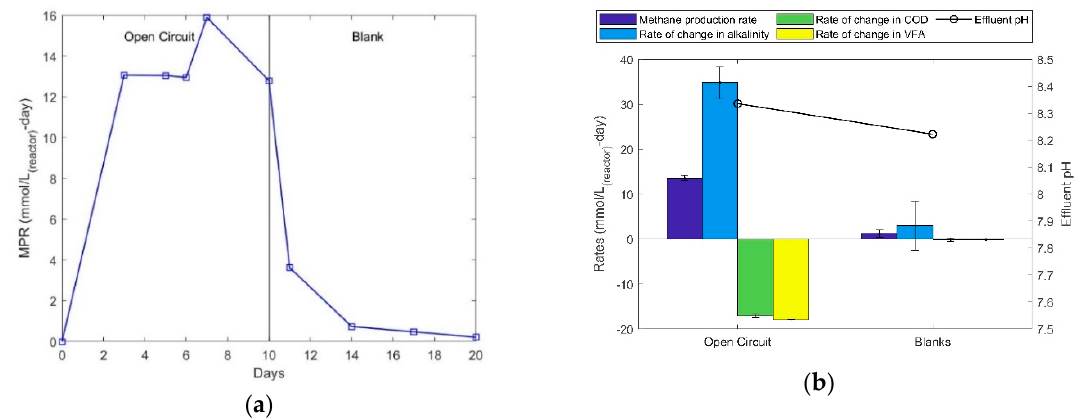
Figure 1: ( a ) Methane production rates in open circuit and blank operating modes. ( b ) Rate of different parameters and pH in open circuit and blank operating modes.